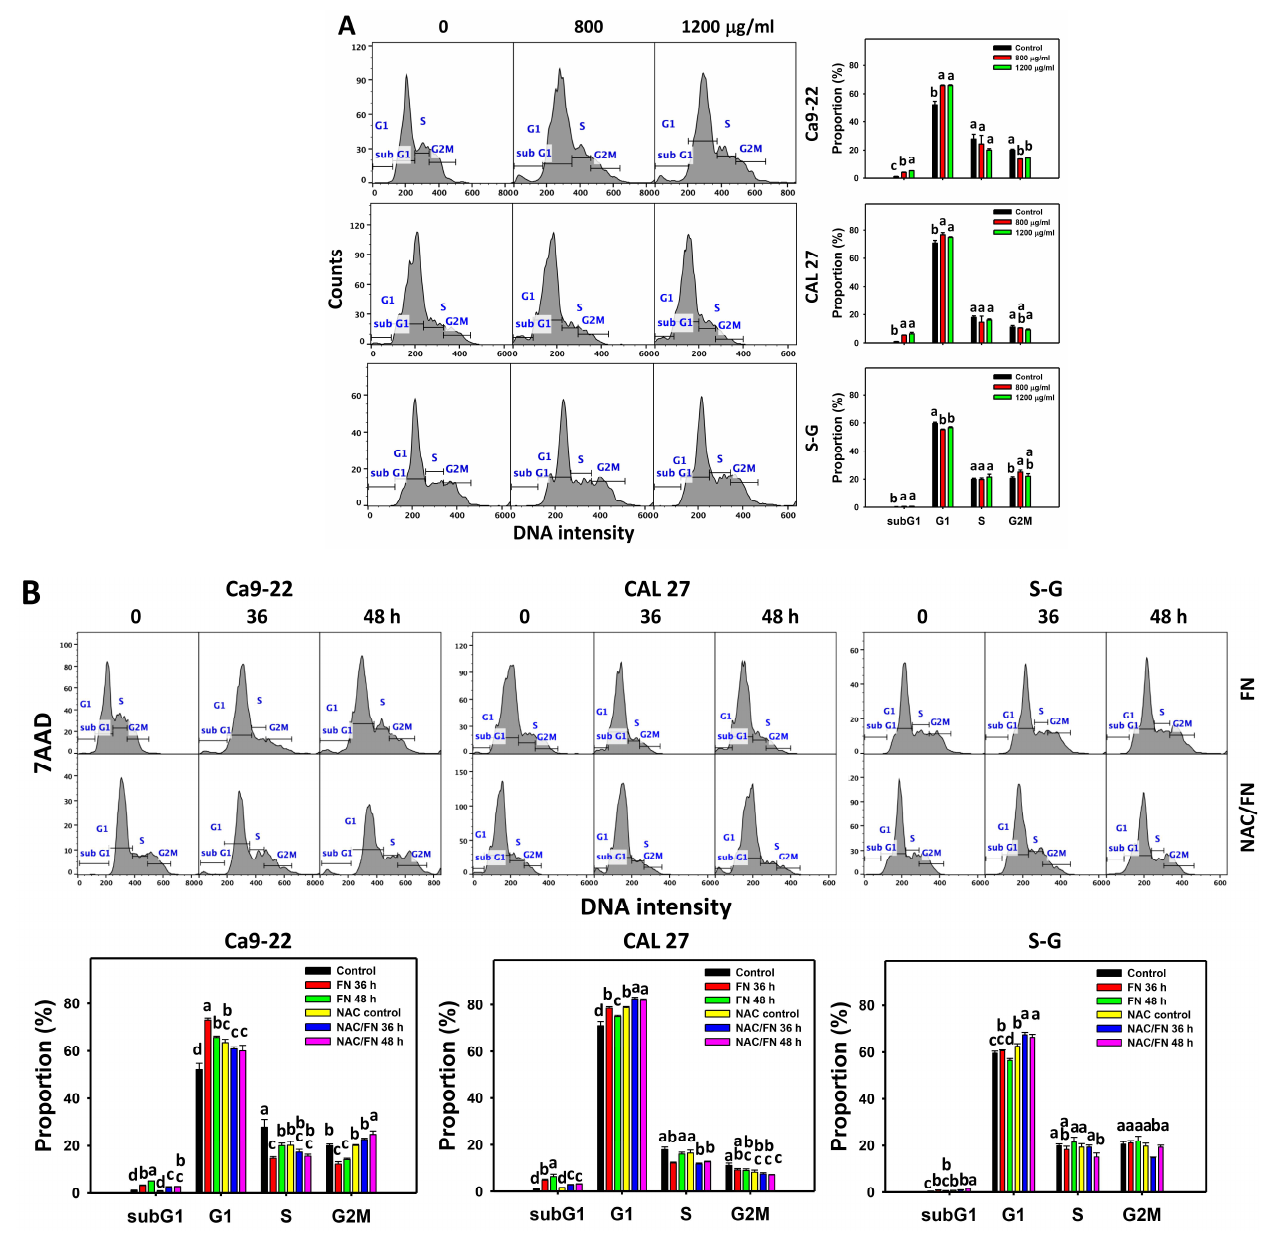
Figure 2. Fucoidan increases subG1 populations of oral cancer cells but not non-malignant cells. ( A ) Cell cycle distribution and statistical analysis. Oral cancer (Ca9-22 and CAL 27) and non-malignant oral cells (S–G) were treated with fucoidan (control, 800 (FN 800), and 1200 (FN 1200) μg/mL) for 0 and 48 h. ( B ) The effect of oxidative stress on the cell cycle change of fucoidan-exposed oral cancer cells. After NAC (10 mM, 1 h) preincubation or not, cells were treated with fucoidan (1200 μg/mL) with NAC co-treatment (10 mM) for 0, 36, and 48 h. NAC/fucoidan (NAC/FN) represents pretreatment with NAC and post-treatment with FN. Data = mean ± SD ( n = 3 experiments). Data with non-overlapping letters reveal significant differences for each phase ( p < 0.05). In the example of Figure 2A (subG1 phase of Ca9-22 cells), FN at 0, 800, and 1200 μg/mL labeled with “d, b, and a” has significant results because the letters do not overlap. In the example of Figure 2B (G1 phase of Ca9-22 cells), control, FN 36 h, and FN 48 h labeled with “d, a, and b” have significant results because the letters do not overlap. In the example of Figure 2B (G2/M phase of Ca9-22 cells), FN 48 h and NAC/FN 48 h labeled with “c and a” have significant results. The positive control of G2/M arrest of the cell cycle is provided in Supplementary Figure S5.